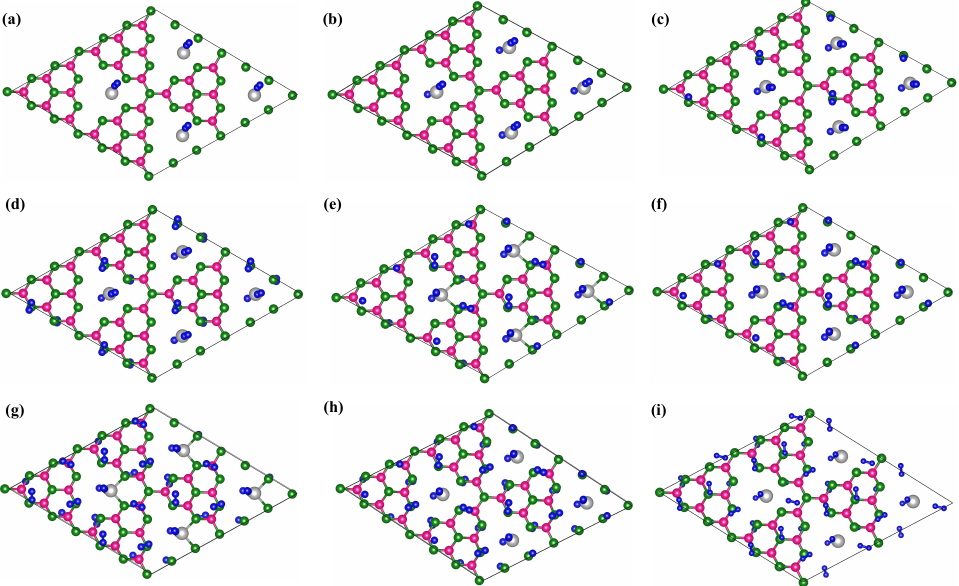
Figure 9. ( a – i ) The optimized configurations of the Al-decorated g-C